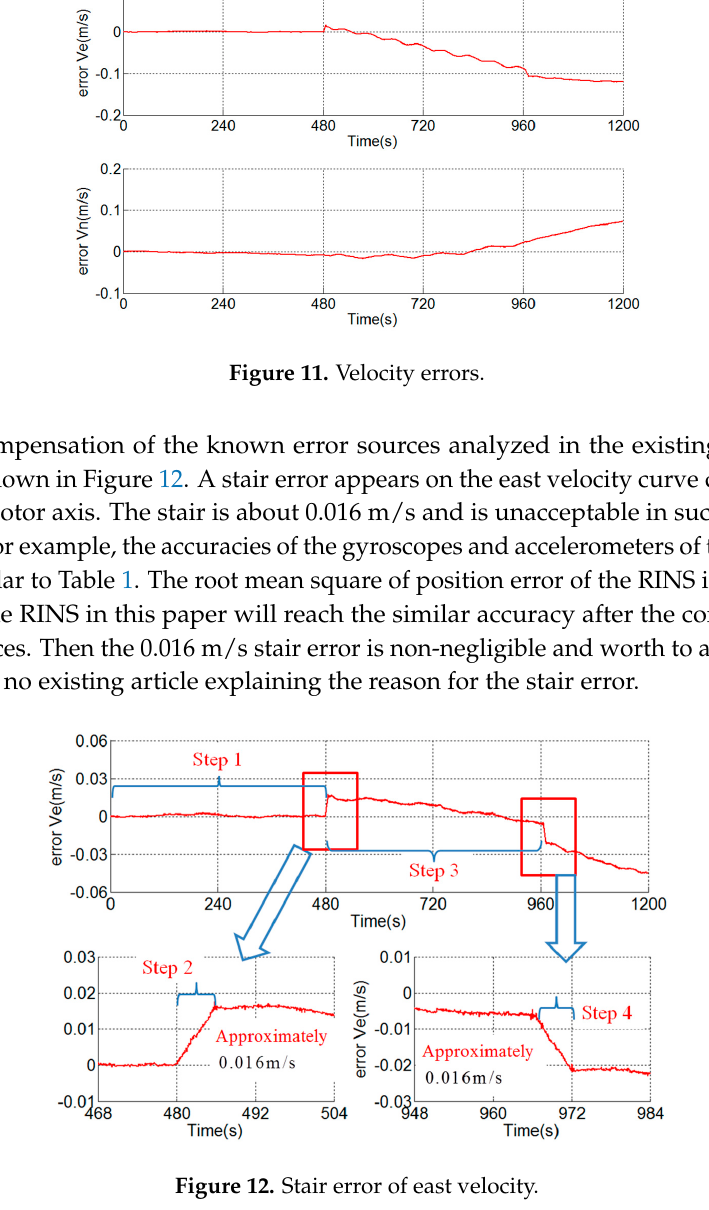
9 of 15 Figure 10. Result of compensation of asynchrony between gyroscope and angular encode. The stair error of the azimuth between forward rotation and backward rotation is 2